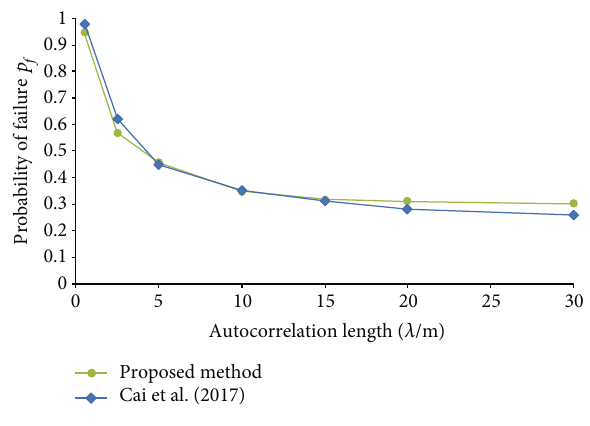
Figure 2: Validation of the proposed method. Table 1: Parameters used for the example in fi nite